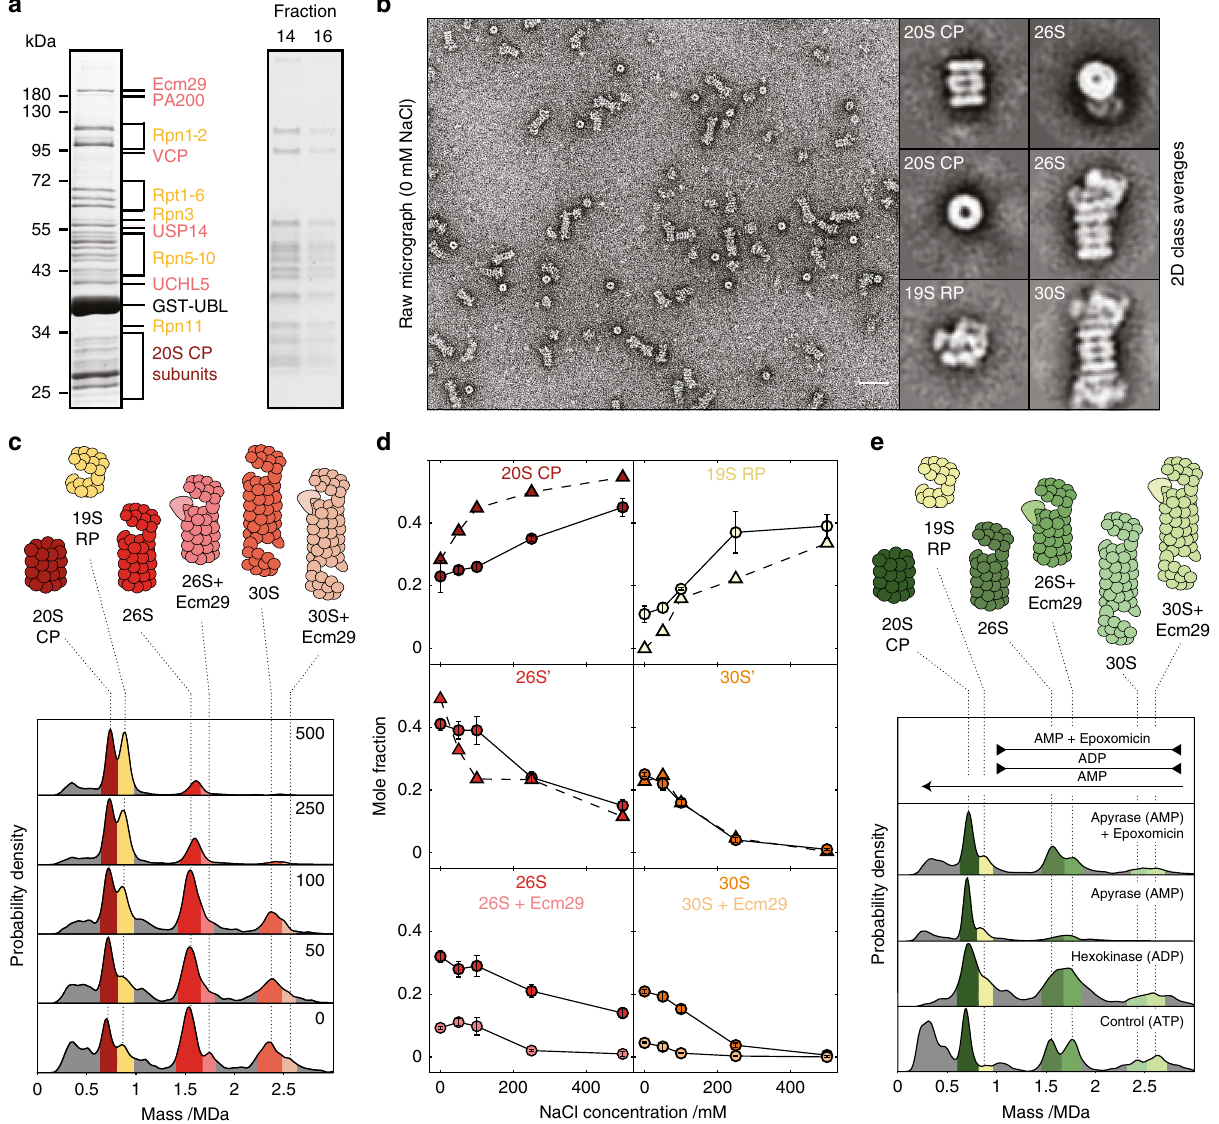
Fig. 3 Proteasome composition, structure, stability, and interactions. a SDS-PAGE gels of two-step af fi nity puri fi cation of proteasomes — pull down with GST-Ubl (left) and separation on 10 – 30% sucrose gradient (right). Individual proteasome subunits are shown in dark red and yellow and PIPs in pink. b Representative negative-stain micrograph and 2D class averages of proteasome complexes generated by nsEM analysis. Scalebar: 50 nm. c MP distributions as a function of NaCl concentration. All reactions were carried out at 4 °C. d Corresponding changes to the abundances of the main species comparing nsEM (triangles) with MP (circles) as well as a breakdown of the main 26S and 30S (dark) and Ecm29-bound (light) species. Error bars are calculated as the standard deviation of mole fractions from different repeats. e MP distributions as a function of different nucleotide conditions. All reactions were carried out at 37 °C. Source data are provided as a Source Data fi